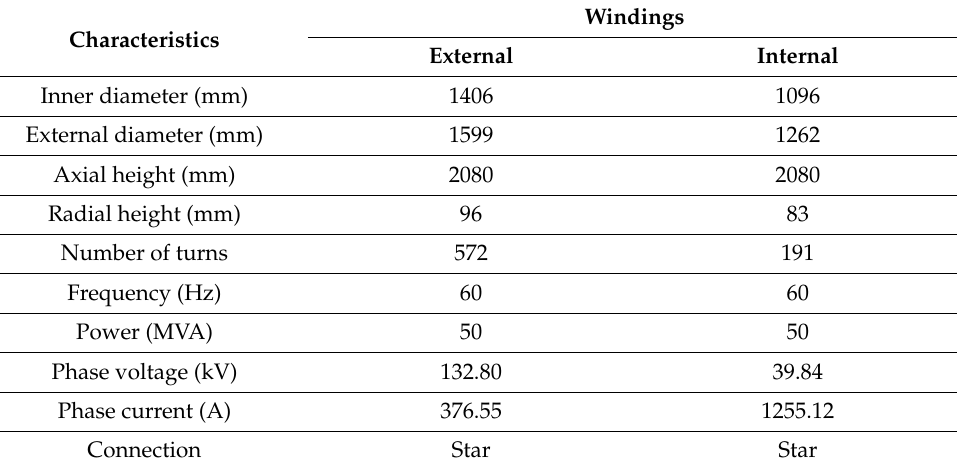
Figure 6. Three-phase bench mounted by three single-phase transformers. Recreated from [21]. Table 1. Characteristics of the 50 MVA transformer.